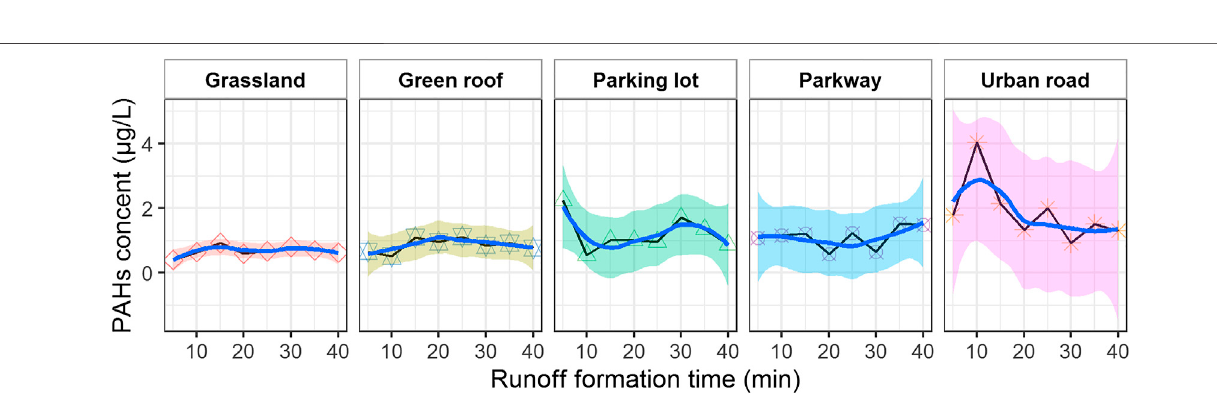
Frontiers in Earth Science |